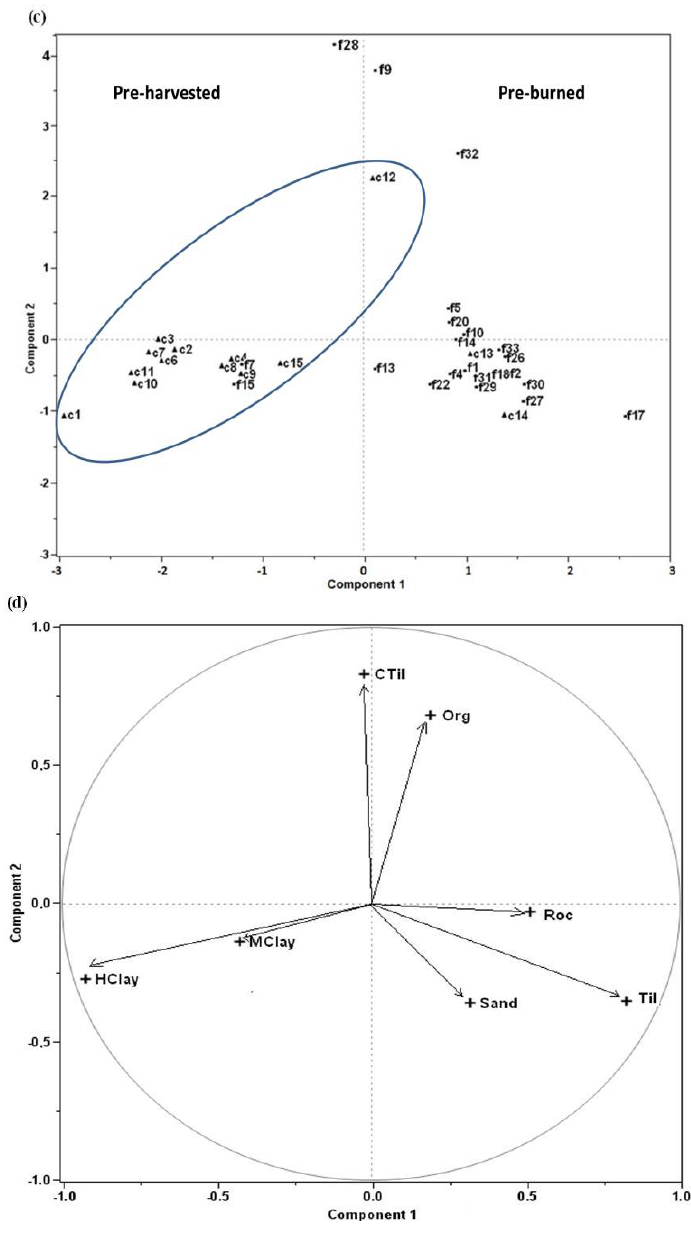
Figure 3. Results of two PCAs based on pre-disturbance vegetation cover types ( a and b ) and the types of surficial deposits ( c and d ) on which the two disturbances occurred for 22 fire events and 14 harvested agglomerations. Data derived from the SIFORT database. Each cover type or surficial deposit is described as its relative proportion (%) within its disturbed area . (a and c) Scores. The letters preceding numbers represent type of disturbance (f = fires; c = harvests), (b and d) Loadings. RegC (coniferous regeneration), RegD (deciduous regeneration), Dist (disturbance), ID (mature forest covers of shade-intolerant deciduous), BH (bare humid), BD (bare dry), JP (mature forest covers of jack pine), H 2 O (water), DeC (mature forest covers of shade-intolerant deciduous), BF (mature forest covers of balsam fir), BS (mature forest covers of black spruce), Roc (rocky outcrops), Til (tills), CTil (cochrane tills), Sand (sand types), MClay (mesic clay), HClay (sub-hydric clay), Org (organic